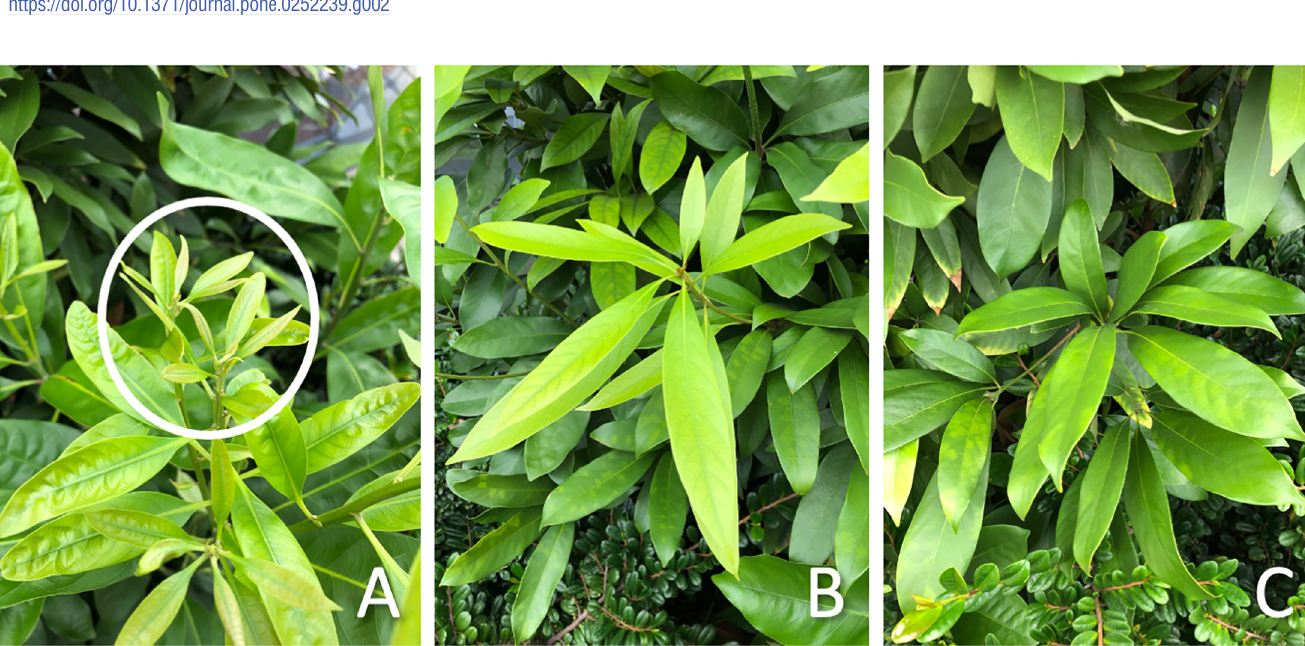
PLOS ONE | https://doi.org/10.1371/journal.pone.0252239 May 26, 2021 4 /